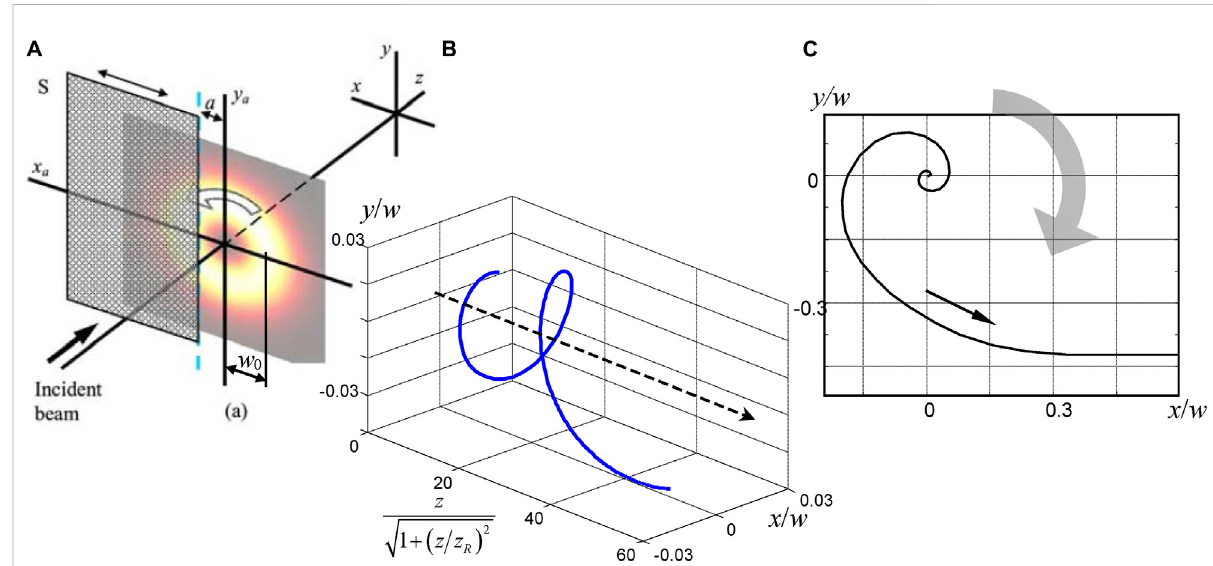
FIGURE 3 (A) SchemeoftheOVbeamdiffraction:anopaquescreenSislocatedinthetransverseplane z =0,wheretheWFoftheincidentbeamis fl at;the distance a between the screen edge and the beam axis is adjustable, the diffraction pattern is observed in the z plane furnished with the coordinate frame ( x , y ); (B) 3D trajectory of the amplitude zero in the diffracted LG 0 − 1 beam ( l = – 1) at a fi xed screen position a = 1.4 w 0 (see Equation 5 and comments thereto); (C) the trajectory described by the OV core of the same beam in a fi xed observation plane z = 0.57 z R when the screen is translated in the diffraction plane from a = 2.1 w 0 to a = 0.14 w 0 (view from the positive end of the z -axis). Broad arrows on (A) and (C) show the direction of energy circulation in the incident beam, all transverse dimensions are given in units of the current radius w (cid:1) w 0